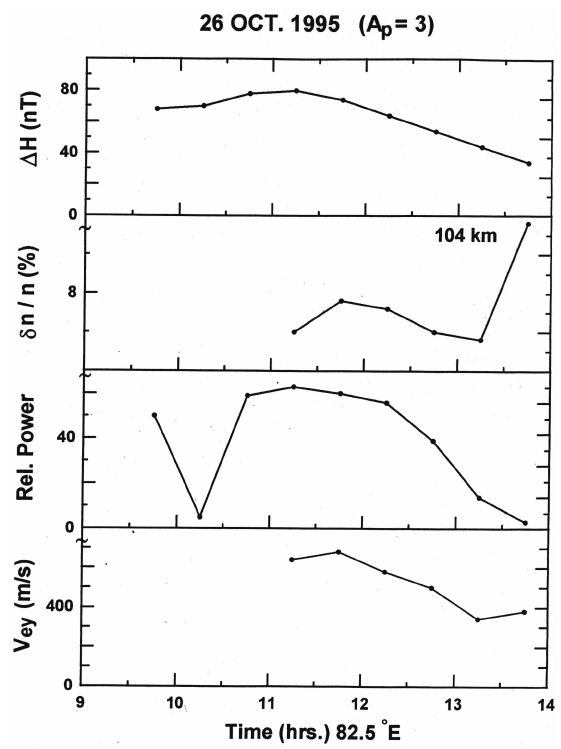
Fig. 10. Same as Fig. 5, but for 26 October